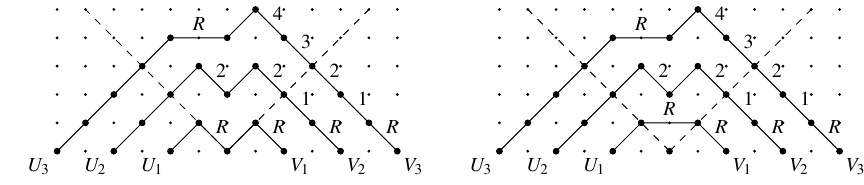
Figure 8: On the left, a disjoint collection σ in X ( U 1 , U 2 , U 3 ; V 1 , V 2 , V 3 ) , which includes a dip down to the origin, with the path weighting W rB marked on. On the right, the dip is replaced with a flat step with the alternative weighting (essentially W 2 ) marked on it. The dashed lines mark the region in which collections can do something